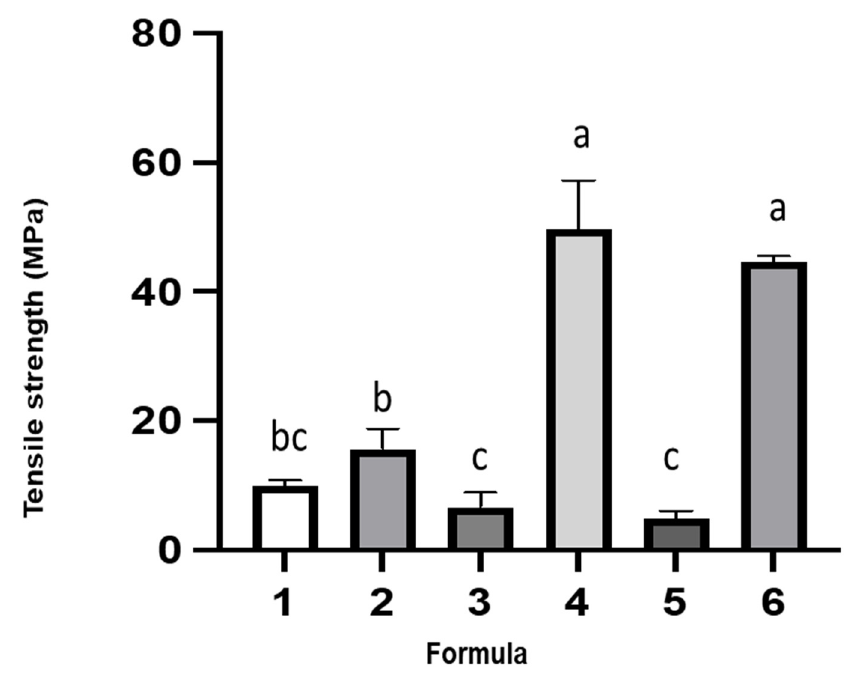
Figure 2. Tensile strength (MPa) of the 6 film formulas. The different letters represent a significant difference of p < 0.05. The error bar indicates the standard deviation (n = 3).